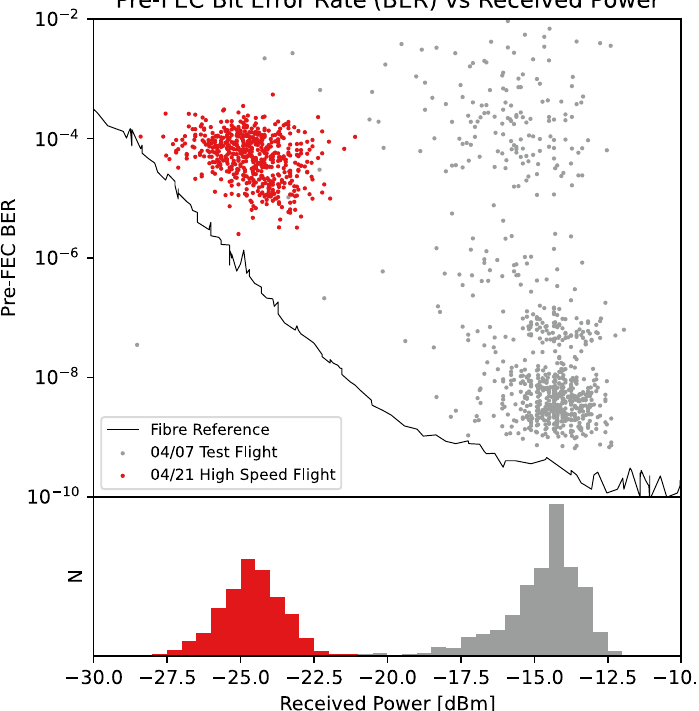
Figure 7. Top: pre-FEC BER versus received power. The black line is measurements taken in-fiber, delineating best possible performance. The gray dots are measurements from the 2022/04/07 test flights, red dots are from the 2022/04/21 high speed flight. Bottom: histogram of received power. Gray is from 2022/04/07 test flights, red is from 2022/04/21 high speed flight.